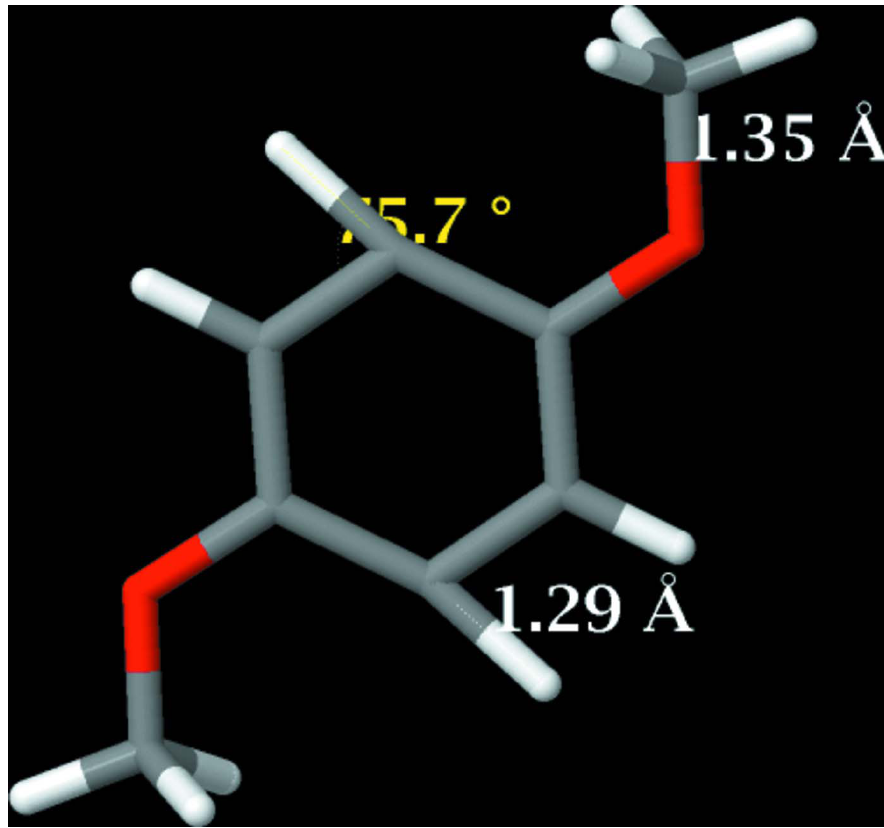
Figure 1 The structure of (I) according to Goodwin et al.